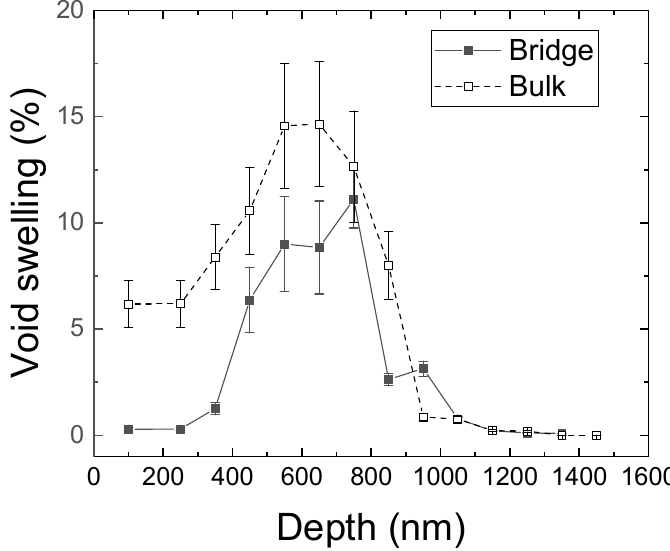
Figure 6. Comparison of depth dependence of swelling distributions in the bridge of 1.7 thickness and in the region far away from the bridge.